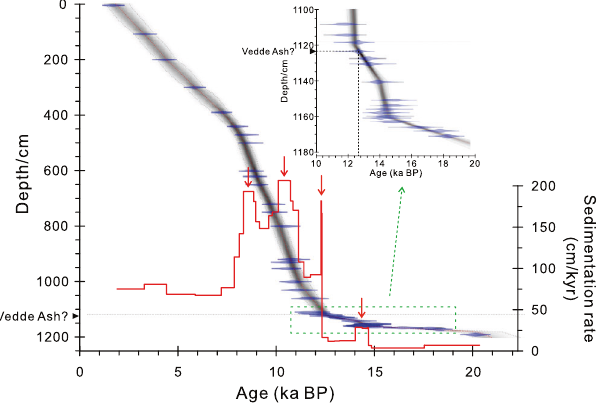
Fig. 2 Age model of Core MSM12/2-5-1. Bayesian age-depth model was established based on 38 radiocarbon dates (see Supplementary Table 1) using the Bacon program 75 . The horizontal dashed lines indicate sediment depths where sedimentation rates change signi fi cantly. Grey stippled lines indicate 95% con fi dence intervals of calibration age. The red line shows linear sedimentation rates (LSR) based on the calibrated age control points; red arrows highlight the intervals of maximum LSR. The black triangles mark the depth of a prominent tephra layer that probably represents the Vedde Ash layer 32